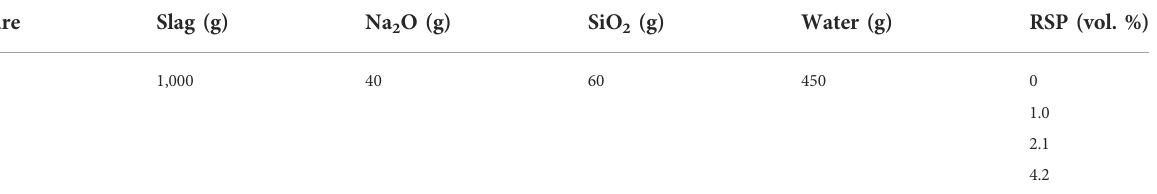
TABLE 2 Mix proportions of alkali-activated slag pastes.